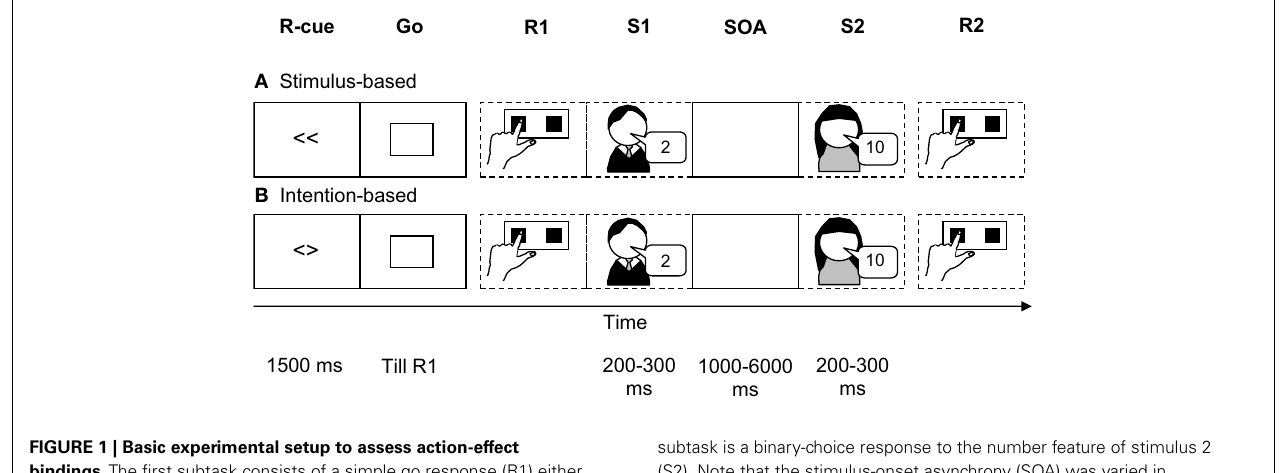
FIGURE 1 | Basic experimental setup to assess action-effect bindings. The first subtask consists of a simple go response (R1) either in a stimulus-based (A) or intention-based (B) action mode which triggered the auditory presentation of stimulus 1 (S1).The second